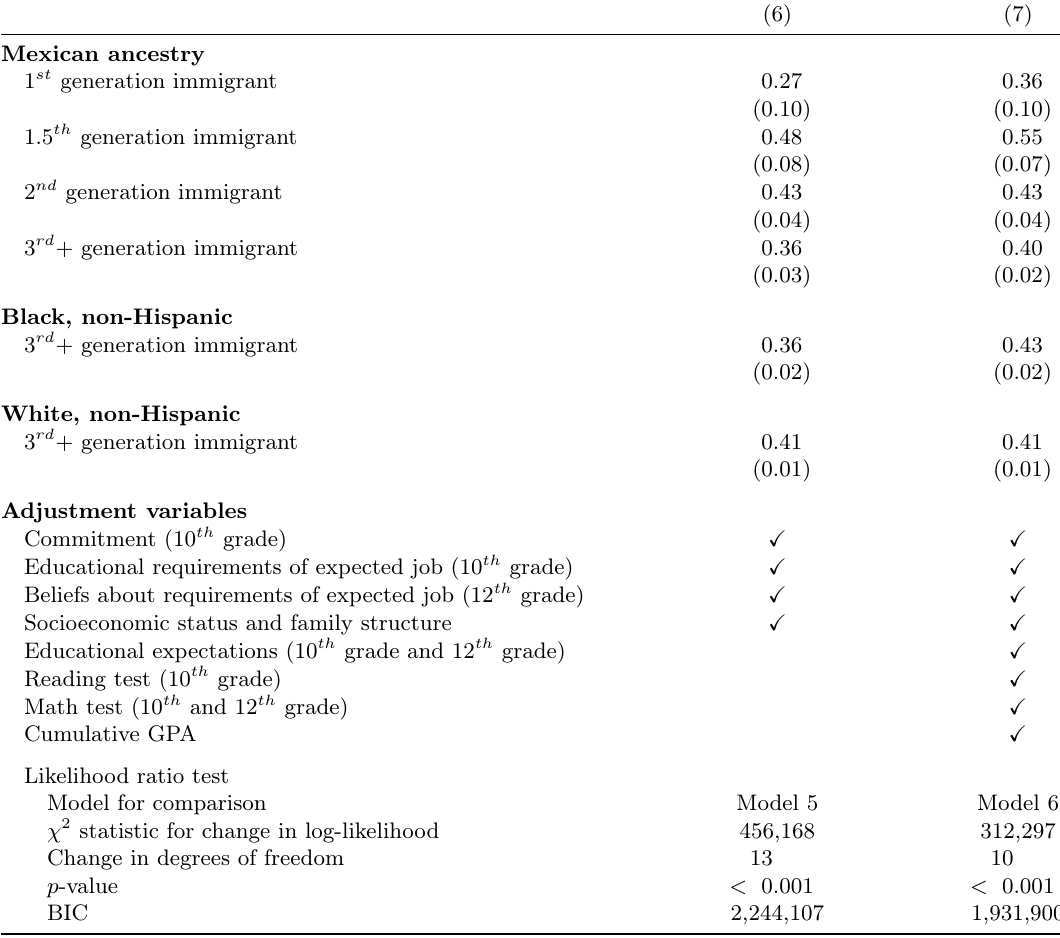
Table 7: Additional Adjusted Proportions for Bachelor’s Degree Receipt by